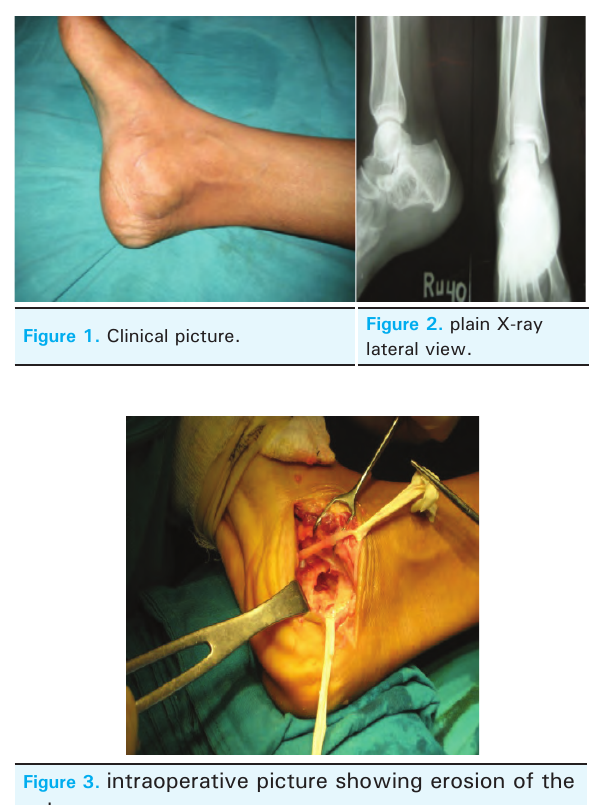
Figure 5A. interconnected cords, strands and loose clusters of eosinophilic spindle shaped tumor cells separated by abundant myxoid stroma.